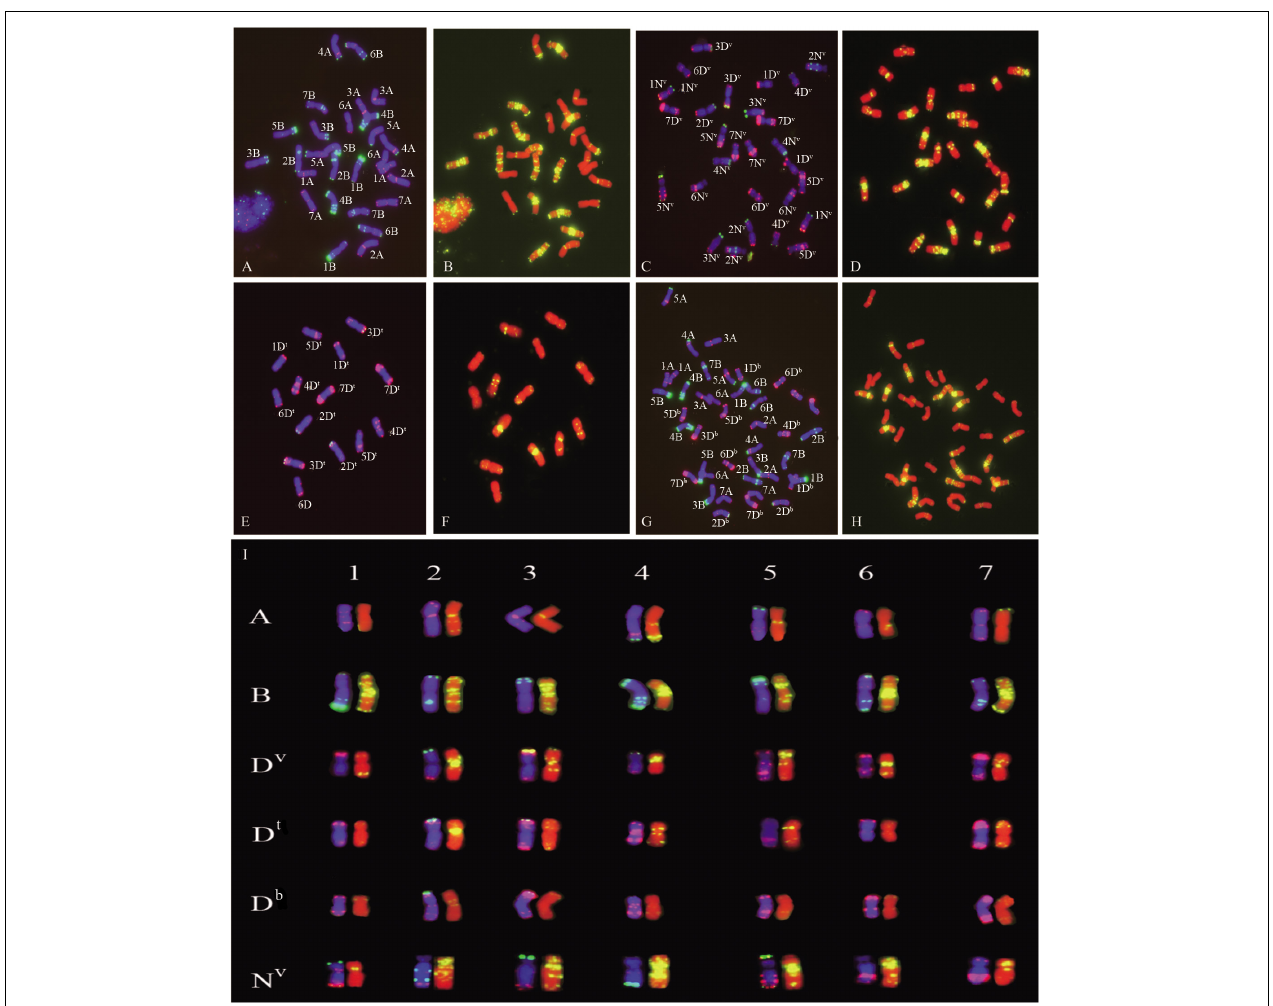
FIGURE 3 | FISH analysis of T. turgidum cv. Langdon (A,B) , Ae. ventricosa cv. RM271 (C,D) , Ae.tauschii SQ 665 (E,F) , common wheat Chinese Spring (CS) (G,H) , and the karyograms of the A, B, D v , D t , D b , and N v subgenomes (I) . (A,C,E,G) chromosomes stained by DAPI (blue), oligo-nucleotides Oligo-pSc119.2 (green), and Oligo-pTa535 (red). (B,D,F,H) Chromosomes staining with DAPI (red) and Oligo-(GAA) 7 (yellow). A, B in panel (I) are the subgenomes of T. turgidum cv. Langdon; D v and N v are the subgenomes from Ae. ventricosa cv. RM271; D t is the genome originated from Aegilops tauschii cv. SQ 665; D b is the subgenome from bread wheat Chinese Spring